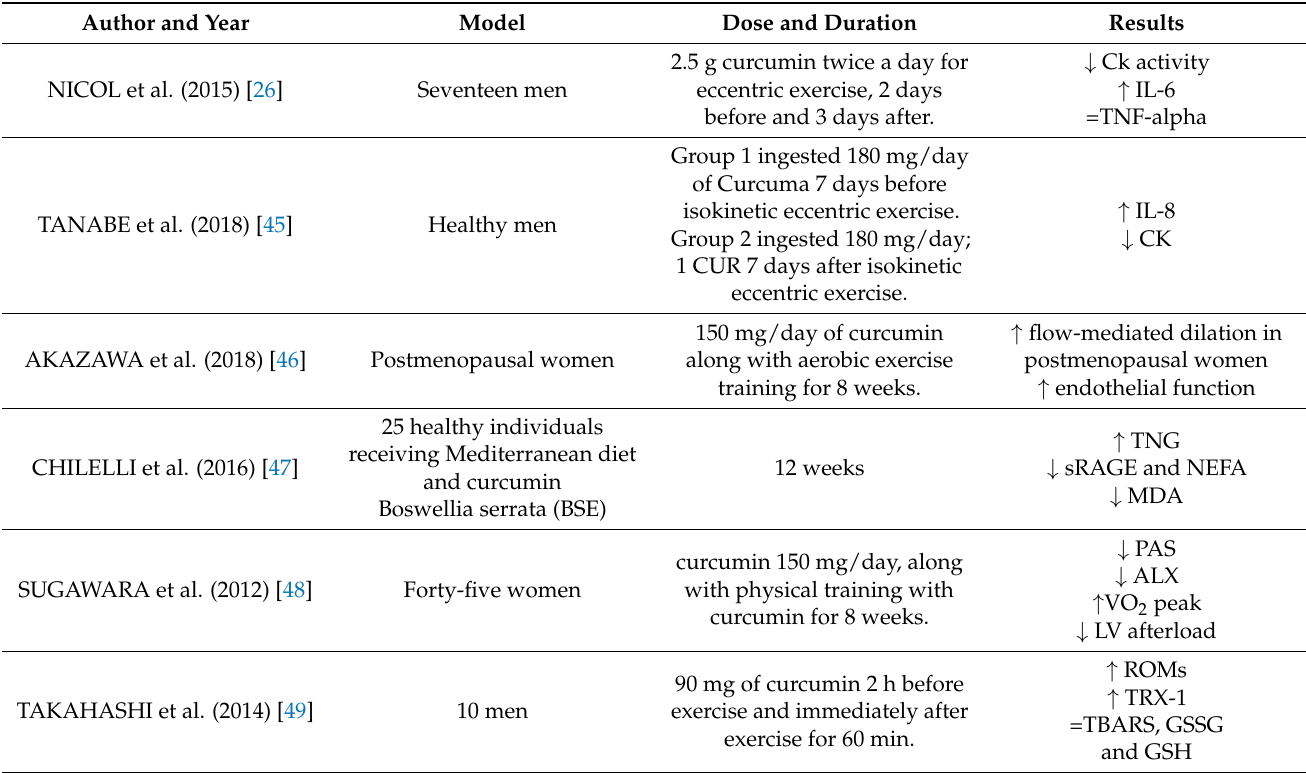
Table 2. Articles selected with healthy individuals submitted to turmeric supplementation and/or associated with physical exercises. Papers were analyzed and selected according to predetermined inclusion